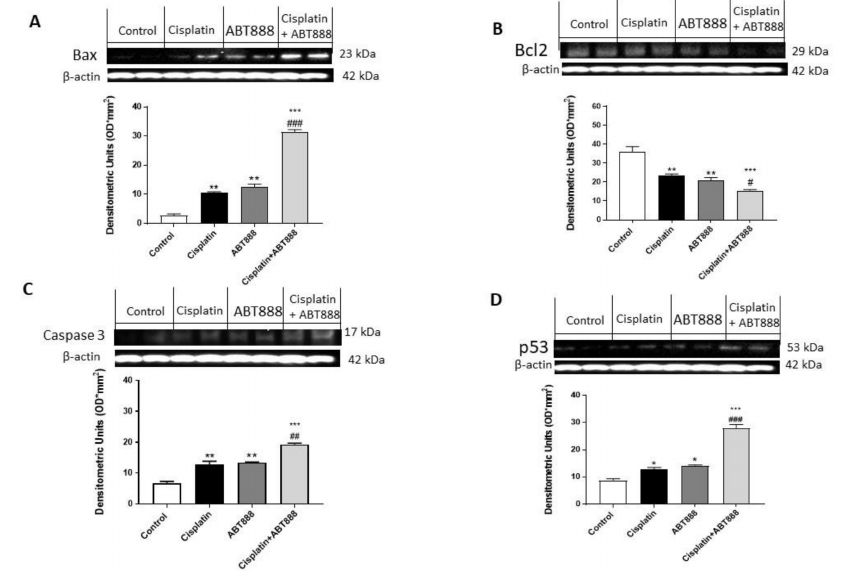
Figure 4. Effect of ABT888 and cisplatin on apoptosis pathway in HSC-2 cell line. The blots revealed an increase in Bax, caspase-3 and p53 expression in the group with the combinatory treatment of ABT888 and cisplatin (Figures A , C and D , respectively) compared to the single treatments and control group, whereas Bcl2 expression was significantly reduced in the combinatory treatment of ABT888 and cisplatin, compared to control group (Figure B ). ( A ) ** p < 0.01, *** p < 0.001 vs. the control; ### p < 0.001 vs. cisplatin group. ( B ) ** p < 0.01, *** p < 0.001 vs. the control; # p < 0.05 vs. cisplatin group. ( C ) ** p < 0.01, *** p < 0.001 vs. the control; ## p < 0.01 vs. cisplatin group. ( D ) * p < 0.05, *** p < 0.001 vs. the control; ### p < 0.001 vs. cisplatin